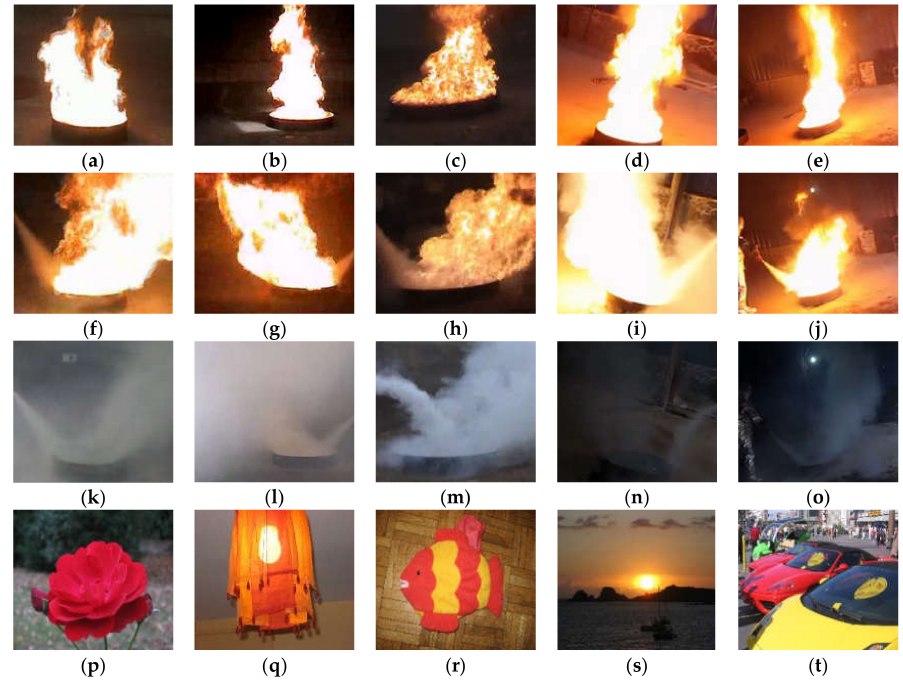
Figure 3. Candidate images: ( a – e ) stable burning state; ( f – j ) extinguishing state; ( k – o ) final extinguished state; ( p – t ) non-flame